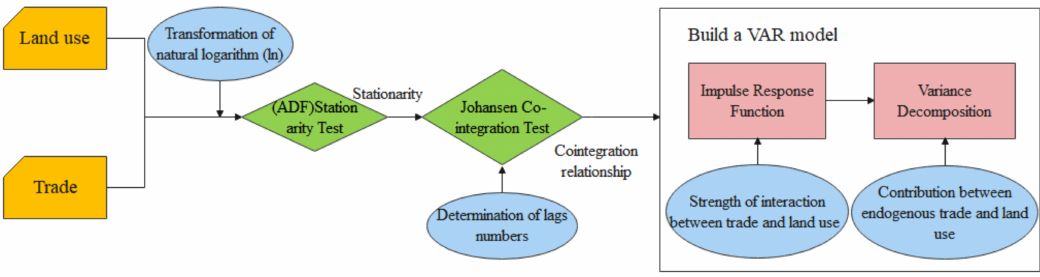
Figure 2. VAR model flow